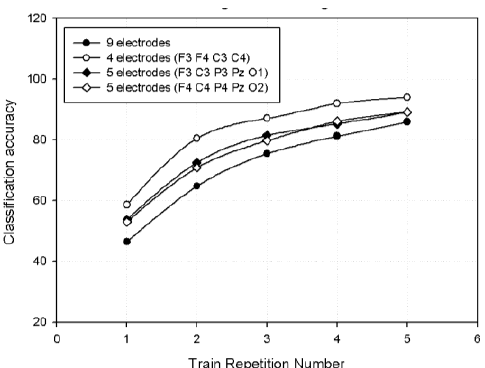
Figure 6. Change in classification accuracy for right hand imagination with